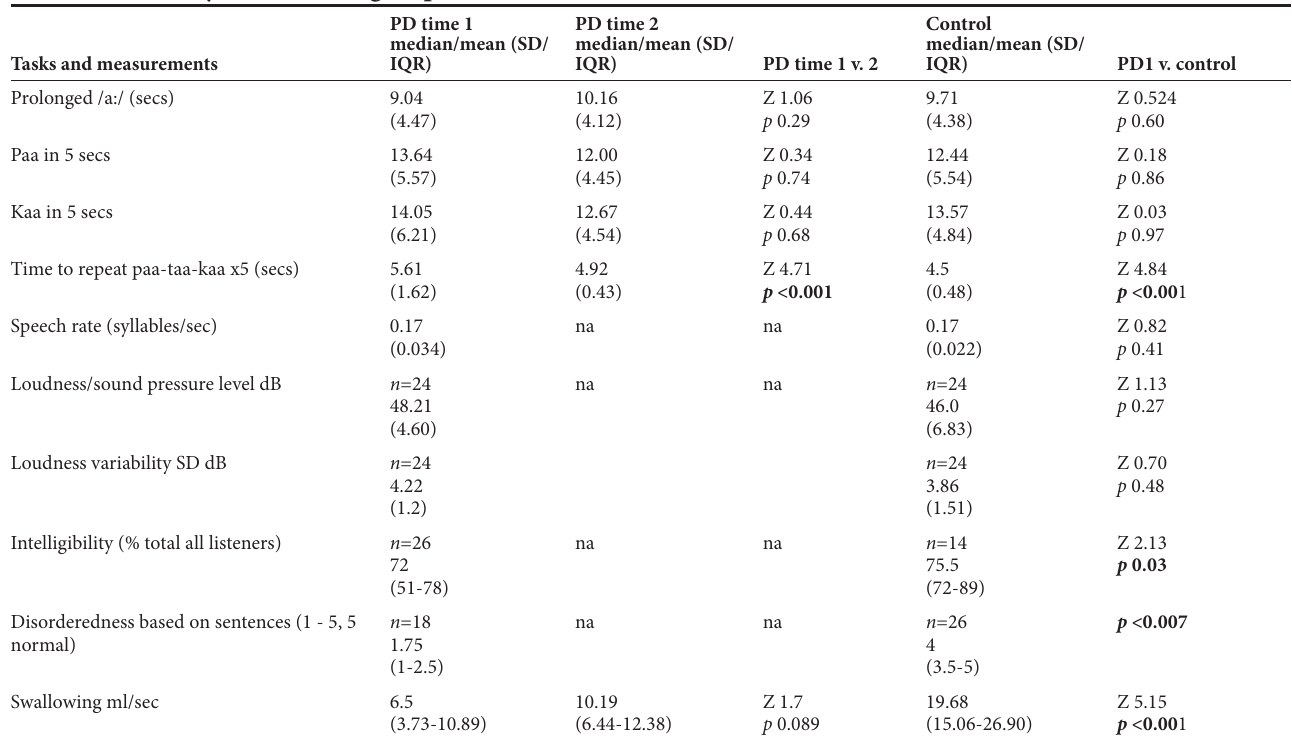
Table 1. Summary statistics for groups Tasks and